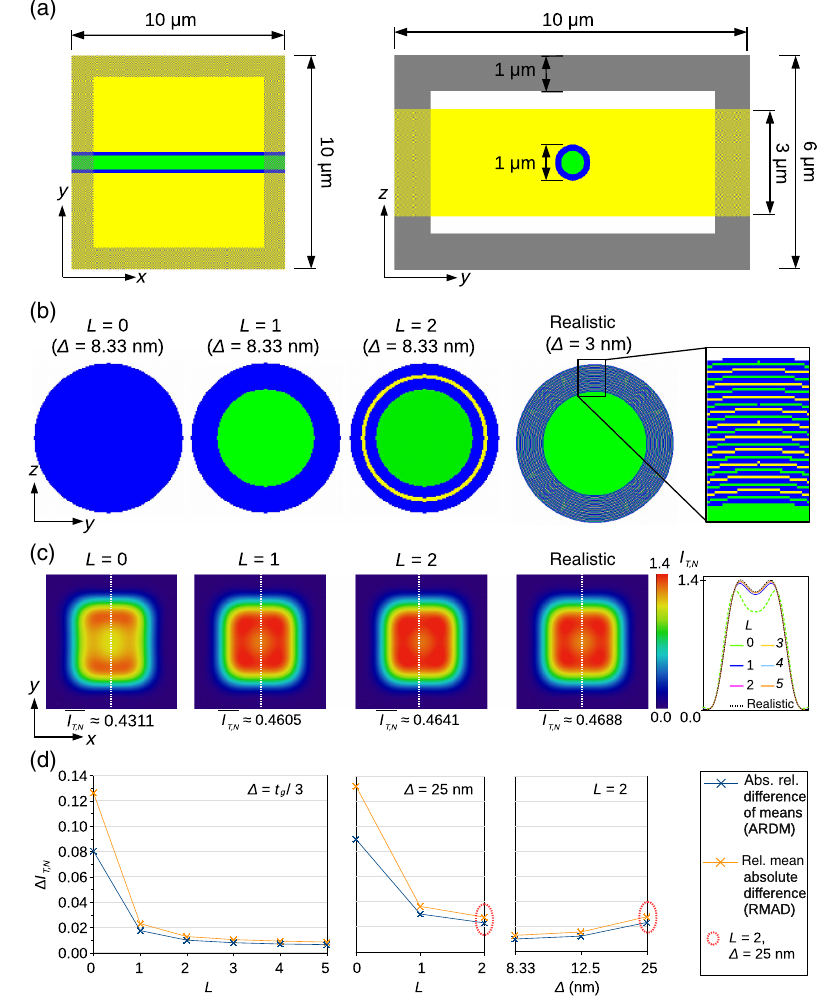
FIG. 17. Error estimation for different numbers of myelin layers. (a) Dimensions of the simulation volume ( xy or yz plane) used to simulate a straight single fiber with different numbers of myelin layers. (b) Cross section through fibers with different numbers L of myelin layers and different Yee mesh sizes Δ . All fibers are modeled with a diameter of 1 μ m, consisting of an inner axon (green) with a diameter of 0 . 65 μ m and a surrounding myelin sheath with a thickness of 0 . 175 μ m. The myelin sheath is composed of alternating layers of myelin (blue) and glycerin (yellow), and the myelin layers are 3 times thicker than the glycerin layers. The realistic model of the myelin sheath contains 22 layers of 5-nm-thick cell membranes (blue), interrupted by 3-nm-thick alternating layers of cytoplasm (green) and surrounding glycerin solution (yellow), yielding a myelin sheath composed of 43 thin layers. The refractive indices are 1.35 for the axon or cytoplasm (green), 1.37 for the glycerin solution (yellow), and 1.47 for the myelin layers (blue). A motivation of the myelin sheath model and the corresponding refractive indices is shown in Fig. 15. (c) Normalized transmittance images, corresponding mean values I , and transmittance profiles on the right (middle image pixels evaluated along the y axis; see the white dashed lines) obtained T;N from 3D-PLI simulations with different numbers L of myelin layers and Yee mesh sizes defined in (b). The simulations are performed for normally incident light with 550 nm wavelength and simulation parameters specified in Table II. The profiles with nonitalic labels belong to the displayed transmittance images. (d) Relative differences between the transmittance images with different numbers L of myelin layers and different mesh sizes Δ (relative to the glycerin layer thickness t ) and the transmittance image with a realistic myelin g sheath. The values for ARDM (blue) and RMAD (orange) are computed using Eqs. (H1) and (H2); the values surrounded in red belong to fibers with double myelin layers ( L ¼ 2 ) and 25 nm mesh size, which are used for the simulation studies in Secs. III and IV. (dashed curves) are shown in Fig. 18(b). The simulations the 3D-PLI simulations for the bundle of densely grown are performed for a Yee mesh size of 25 nm. For some fibers with inclination angles α ¼ f 0 ° ; 10 ° ; … ; 90 ° g are inclination angles, the simulations for NA ¼ 0 . 15 are performed for the three different wavelengths and five repeated for a smaller mesh size ( Δ ¼ 12 . 5 nm); see the angles of incidence defined above. The resulting trans- black crosses. mittance curves for NA ¼ 0 . 15 (solid curves) and NA ¼ 1